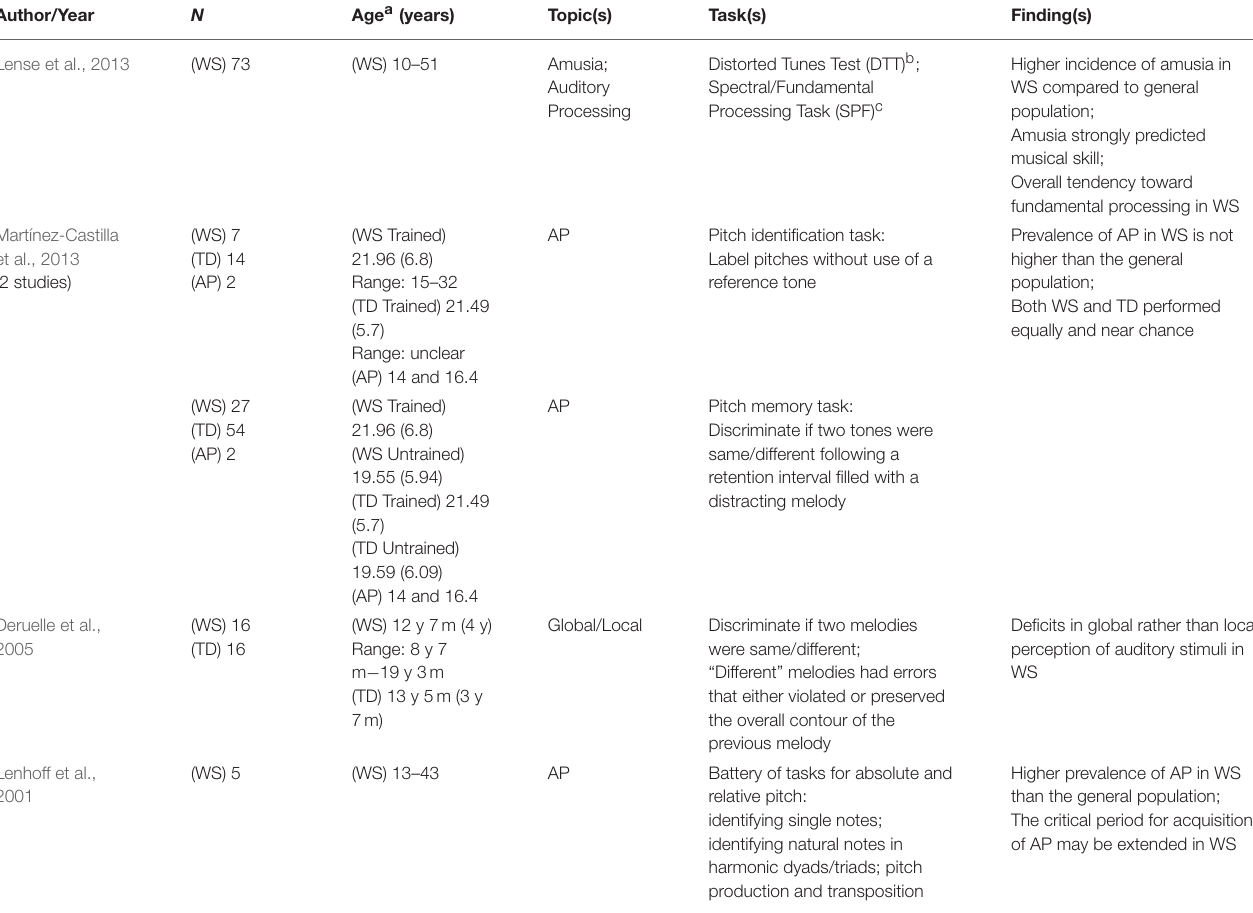
TABLE 5 | Musical processing: absolute pitch, amusia, and auditory